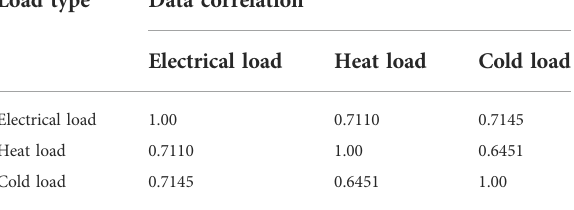
TABLE 3 Correlation analysis between multiple